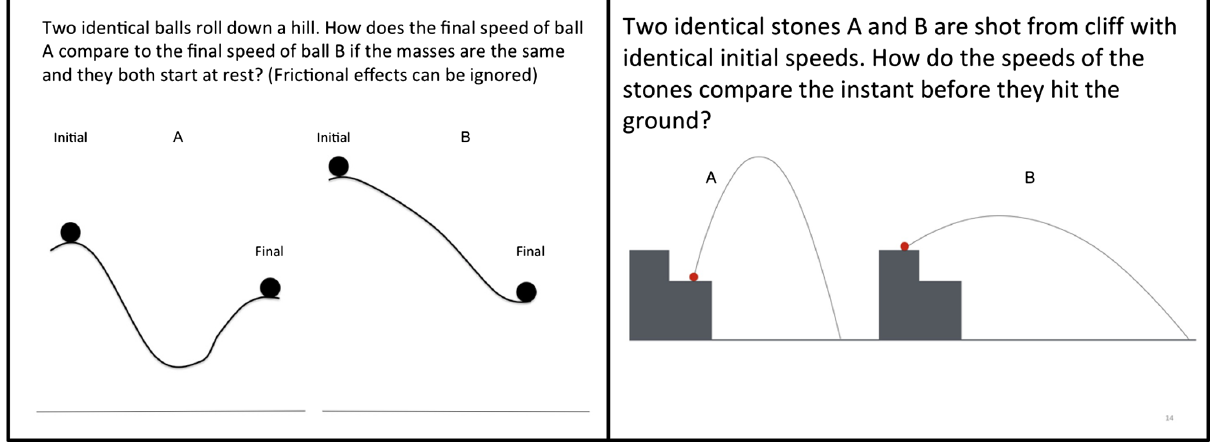
FIG. 3. Example near (left) and far (right) transfer problems (transformation of energy).